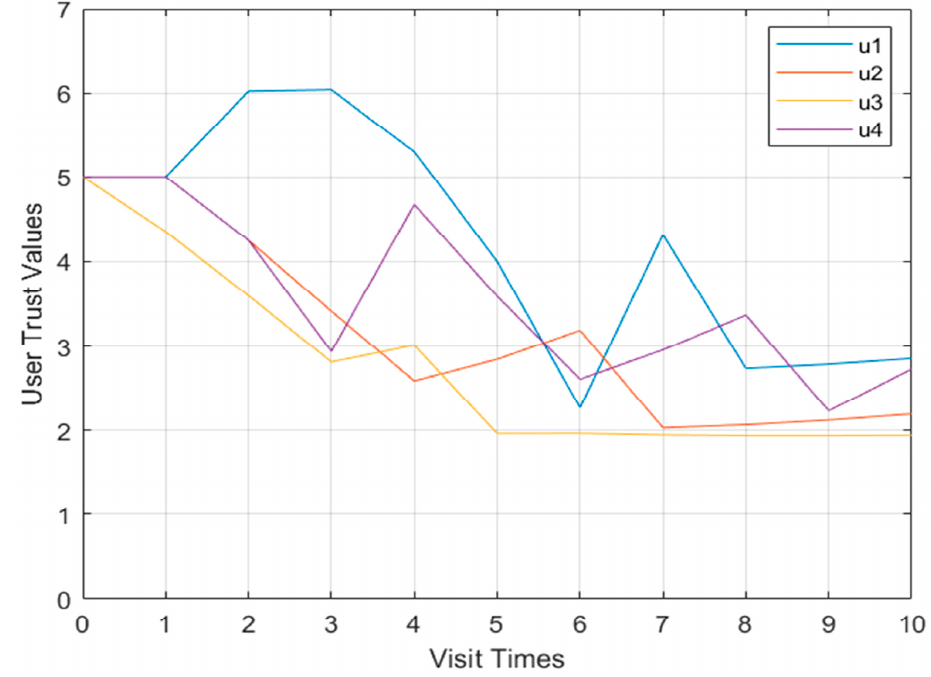
Figure 9. Multi-user trust value change curve of Model 2.